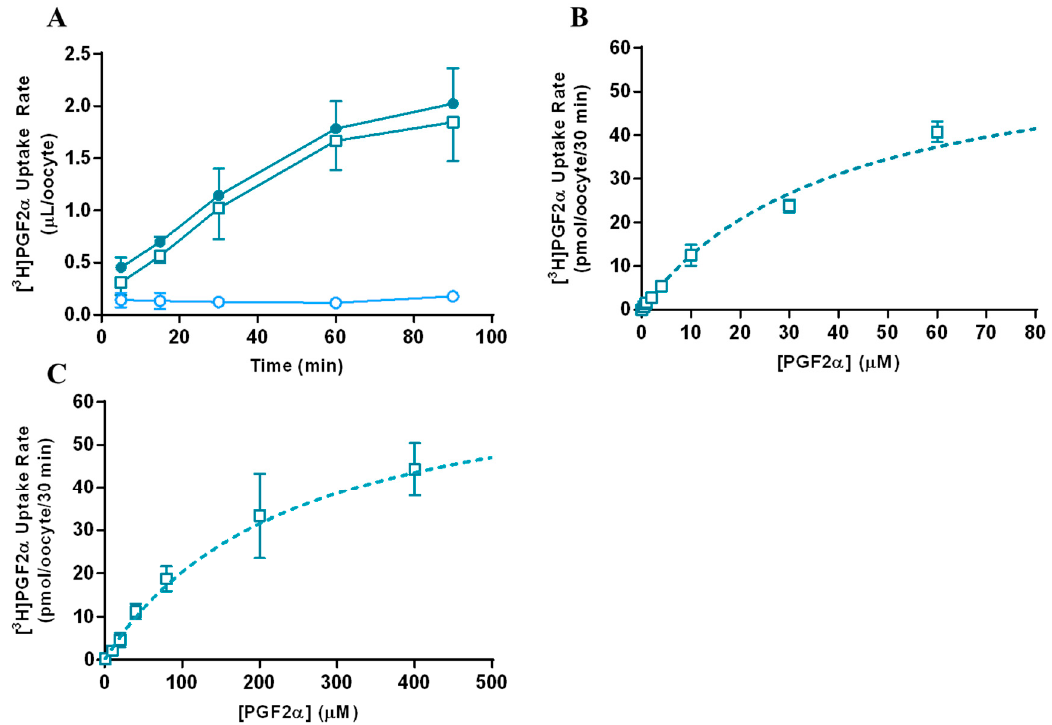
Figure 2. Time- ( A ) and concentration-dependent uptake of prostaglandin F 2 α (PGF2 α ) in murine monocarboxylate transporter 6 (mMct6) ( B ) and human monocarboxylate transporter 6 (hMCT6) ( C )-transfected Xenopus laevis oocytes. (N = 4–5 oocytes / data point). Experiment was performed at least three separate times with at least 2 di ff erent ovaries. Data are presented as mean ± standard deviation (SD). Closed circles: MCT6 cRNA-injected, open circles: water-injected, open squares: MCT6-mediated uptake (MCT6 cRNA-injected minus water-injected). Dashed line represents model fitting using Equation (1) to MCT6-mediated uptake data.